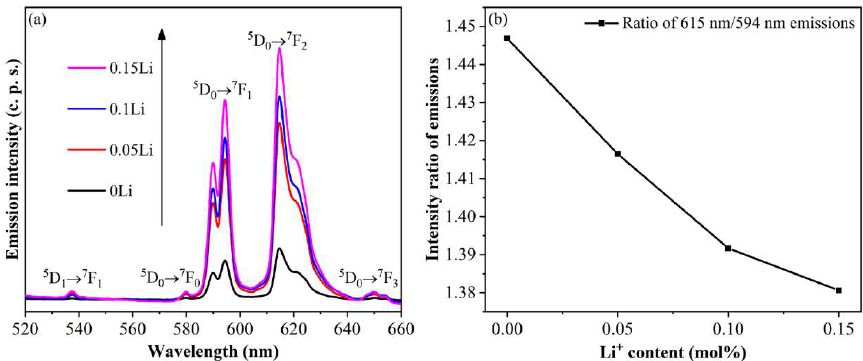
Figure A2. ( a ) The PLS and ( b ) the ratios of 615 nm/594 nm emission for Bi 3.6 Eu 0.4 Ti 3 O 12 : x Li (BETO: x Li, x = 0, 0.05, 0.1, 0.15).